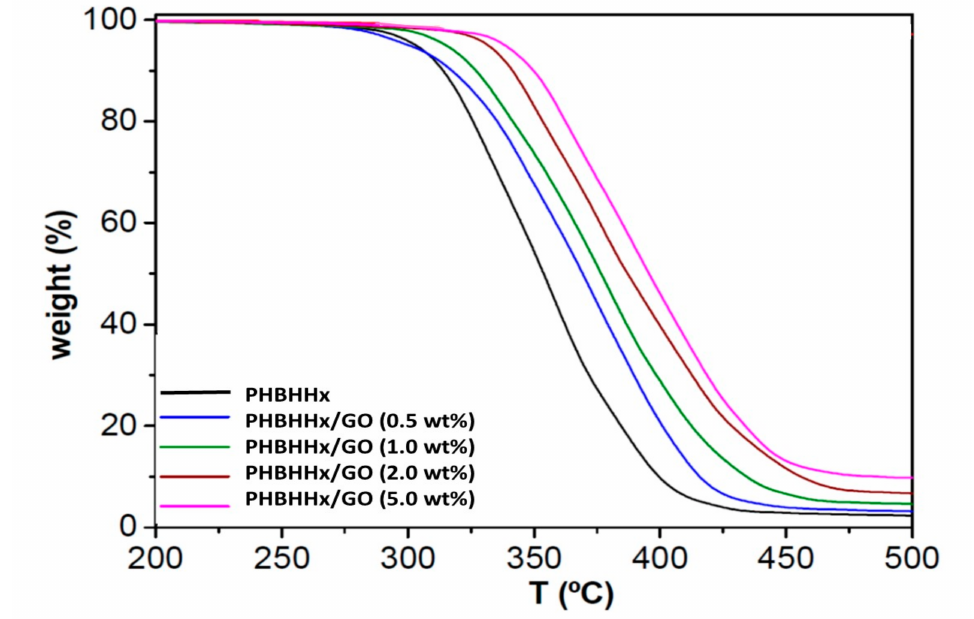
Figure 4. TGA curves of neat PHBHHx and the nanocomposites with different GO